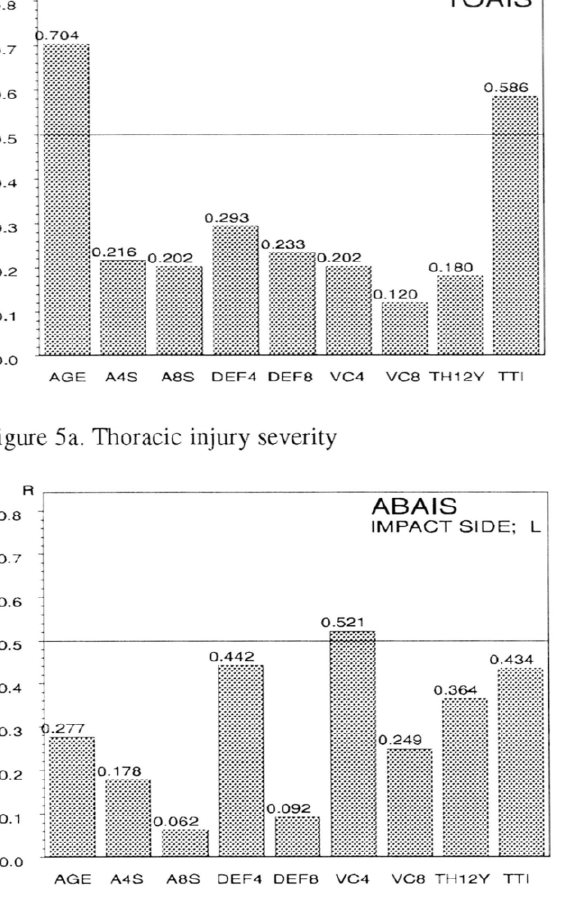
Figure Sc. Abdominal injury severity (left side impact) Figure Sd. Number of rib fractures